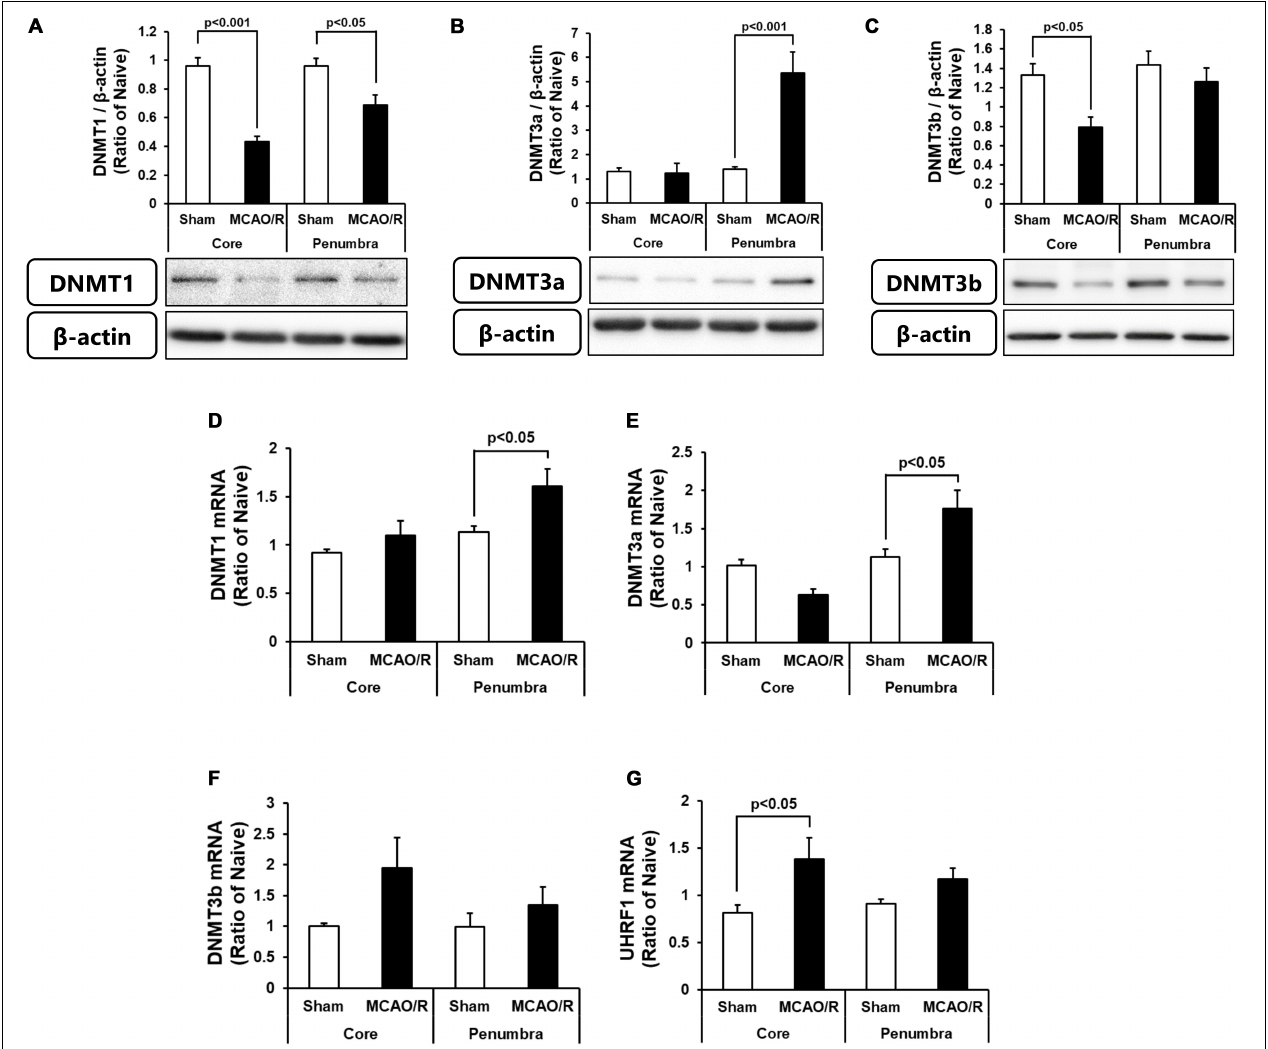
FIGURE 2 | Changes in the protein levels of DNMT1 (A) , DNMT3a (B) , and DNMT3b (C) in the ischemic core and penumbra 24 h after surgery. These DNMTs and β -actin bands were scanned, and the scanned bands were normalized by the naive control on the same blot. β -Actin was used as a loading control. Results are the means ± SD ( n = 5 rats per group). Changes in the mRNA expression levels of DNMT1 (D) , DNMT3a (E) , DNMT3b (F) , and UHRF1 (G) in the ischemic core and penumbra 24 h after surgery. Results are the means ± SD ( n = 6–7 rats per